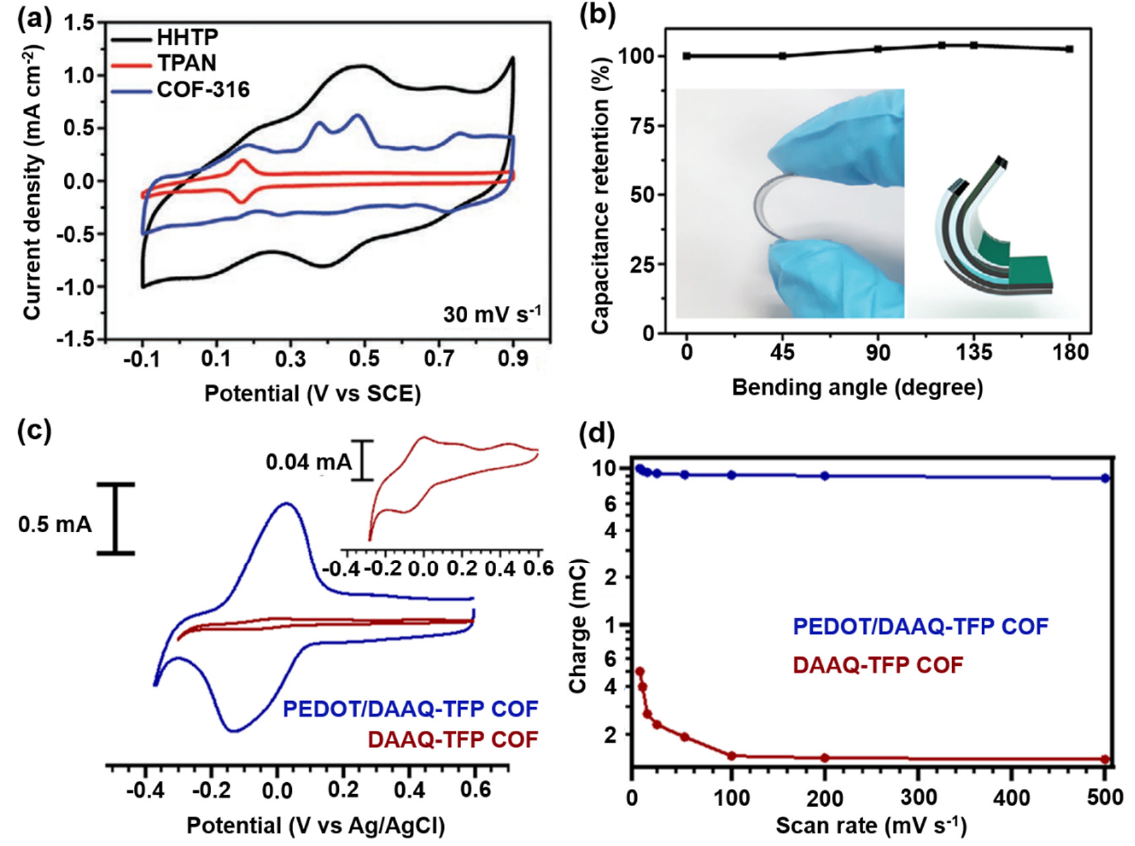
Figure 3. Electrochemical performance enhancement via the post synthetic modification strategy. ( a ) CV curves of COF–316, HHTP, and TPAN at the scan rate of 30 mV s − 1 . ( b ) The capacitance retention curves of COF–316–1@PPy FTCEs under various bending angles of 0°, 45°, 90°, 120°, 135°, 150°, and 180° at 50 mV s − 1 . Inset: The photograph and sketch map of the TFSCs under bending [52]. Copyright 2021, Wiley-VCH. ( c ) CV response at 20 mV s − 1 in 0.5 M H 2 SO 4 of a PEDOT-modified DAAQ–TFP film, 1 μ m-thick (blue), and the same as-synthesized DAAQ–TFP film before EDOT polymerization (red). The inset presents the cyclic voltametric response for the unmodified film using an expanded current scale. ( d ) The integrated charge associated with the oxidative wave of a PEDOT-modified DAAQ–TFP COF film (blue) and unmodified DAAQ–TFP COF film (red) rec- orded over various scan rates indicate that the PEDOT-modified films store more charge and toler- ate faster scan rates than the unmodified films [53]. Copyright 2016, American Chemical Society. Similarly, the synthesized COF is doped to make the bad orbital overlap between organic ligands in COF form conductive channels under the action of redox-active guest molecules, so as to enhance the conductivity of non-conductive COFs [56]. Meng and his co-workers synthesized c-COF by using 2,3,9,10,16,17,23,24-octa-aminophthalocyanine nickel (II) and pyrene-4,5,9,10-tetraone (Figure 4c) [57]. Its intrinsic conductivity is 2.51 × 10 − 3 S m − 1 . This c-COF was then doped with the previously reported I 2 dopant, increasing its conductivity by another three orders of magnitude [58–61]. Similarly, Yang et al. grew a layer of COF film in situ on the substrate under solvothermal conditions, and the con- ductivity increased by four orders of magnitude after doping with iodine, because the anisotropic carrier transport in the frame was conducive to the transfer of out-of-plane holes [62]. At the same time, this conductive columnar stacked COF has good electro- chemical performance, with a long cycling performance (Figure 4d) and a normalized ca- pacitance of 19 μ F cm − 2 . In general, post-synthetic modification can improve the conduc- tivity of COF without destroying the original properties, which is a very promising strat- egy in conductivity modification [53,63,64].